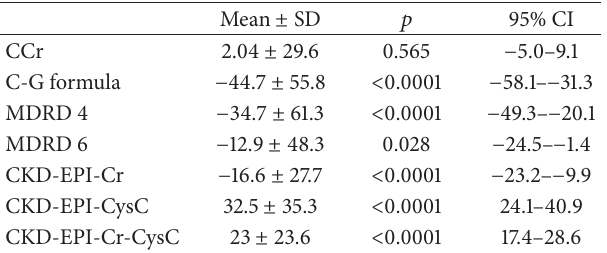
Table 7: Bland-Altman plot analysis for the agreement between isotopic GFR and the other GFR estimating formulae. Mean ± SD